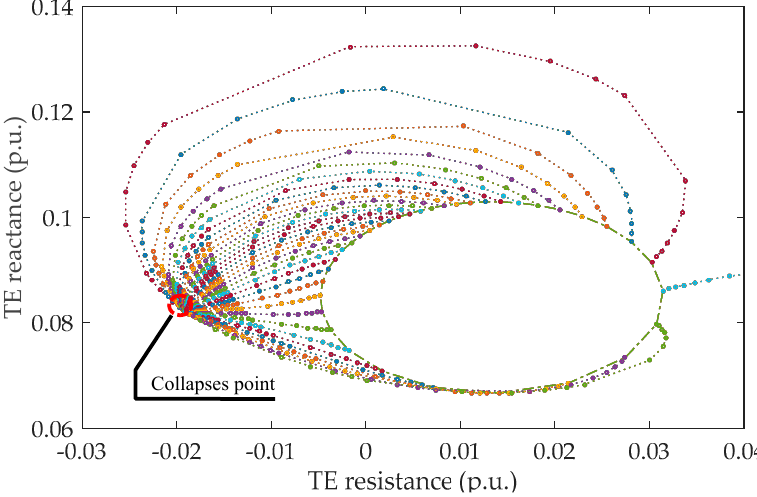
Figure 3. The TE impedance curve of bus 3 for different θ under different load levels.